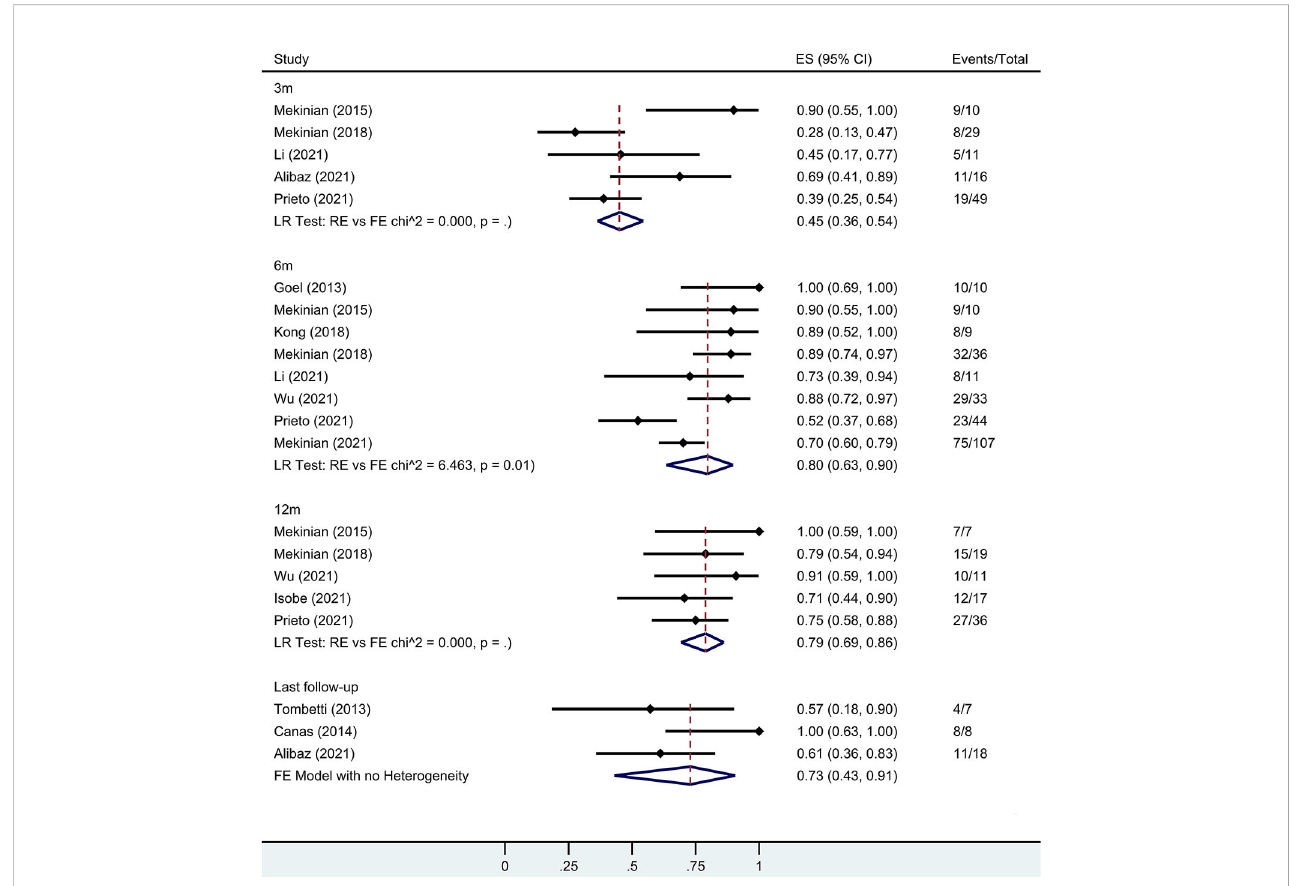
FIGURE 4 Forest plot showing the pooled results of remission rate at the 3-month, 6-month, 12-month and last follow-up. LR, Likelihood Ratio. RE, Random-Effect model. FE, Fixed-Effect